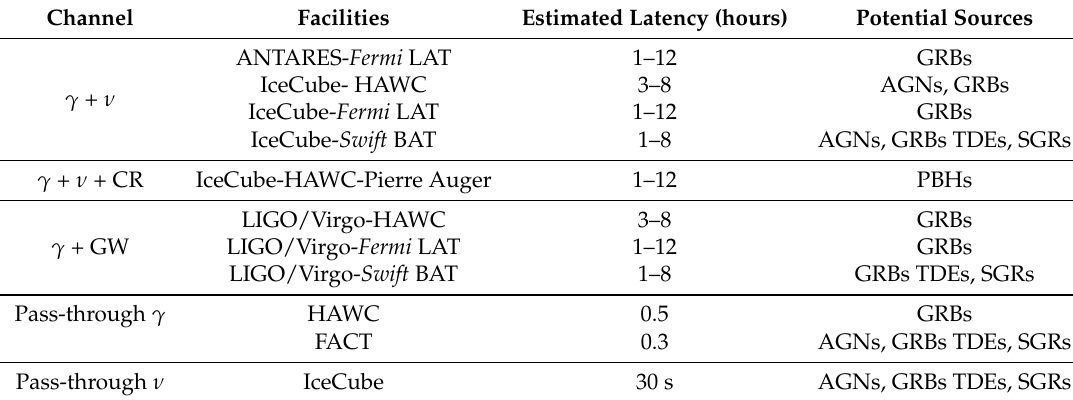
Table 1. Characteristics of different AMON alerts that are in development. Facilities include the detectors used for a specific analysis. Estimated latency considers the time of the generation of the event from the specific observatories. Potential sources show which sources can be monitored (see abbreviations in the Abbreviations